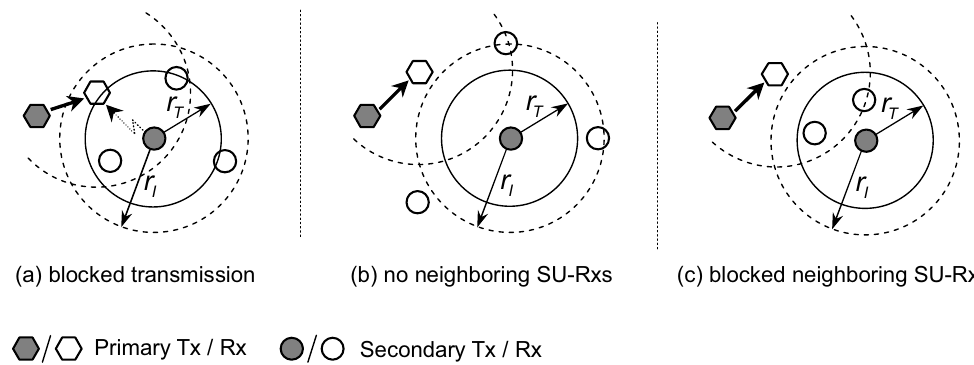
Figure 2. Isolation of secondary transmitter in CRAHNs due to ( a ) blocked transmission, ( b ) no neighboring SU-Rxs, and ( c ) blocked neighboring SU-Rxs,